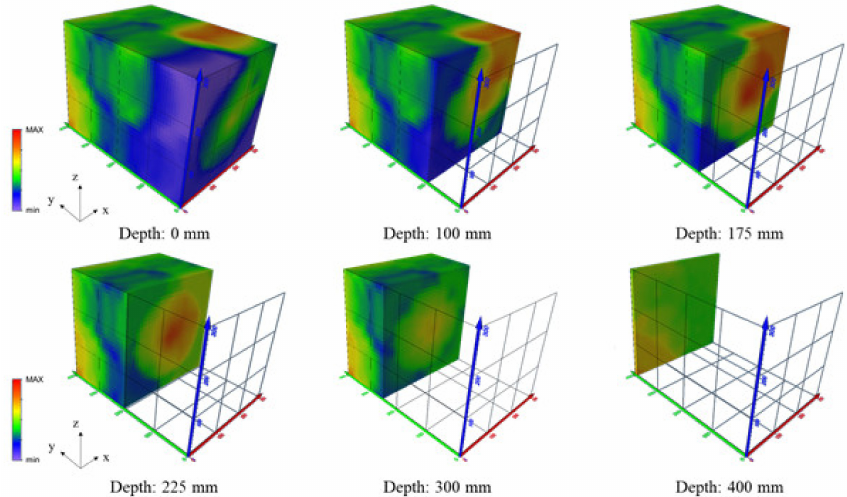
Figure 16. 3D SIBIE result with LDV (Laser Doppler Vibrometer) signal detection for damage-simulated concrete